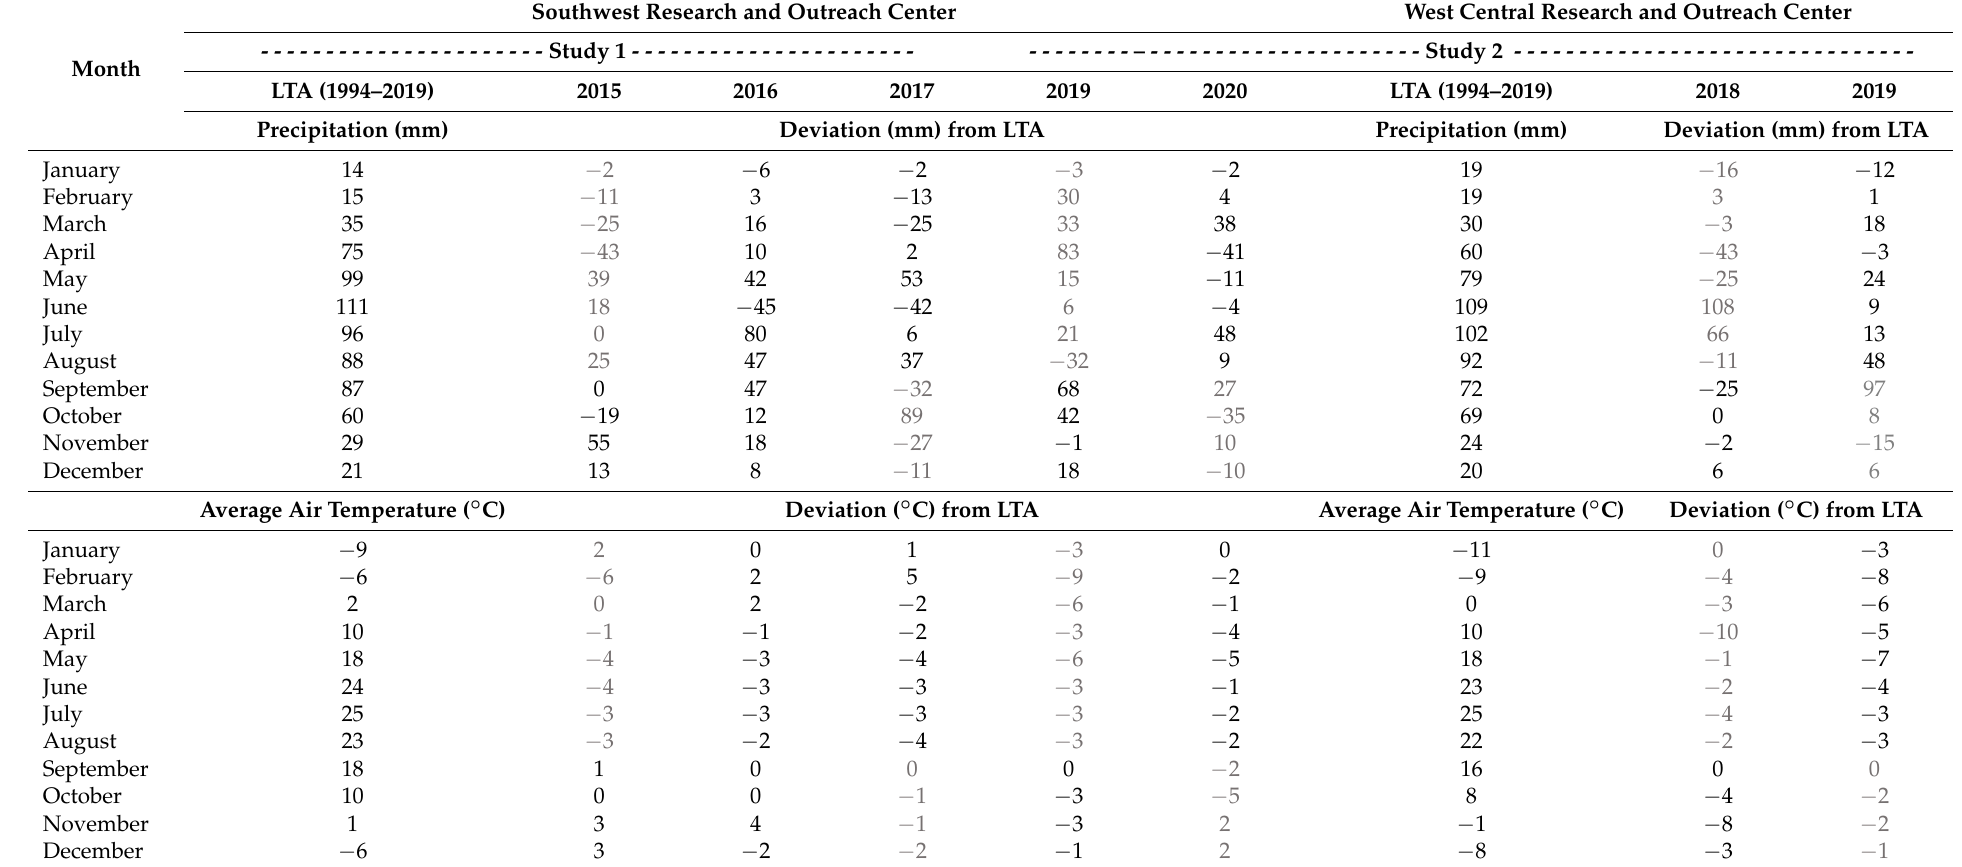
Table 2. Deviations from the long-term averages (LTA) of monthly precipitation and average air temperature (AT) at the experimental locations. Gray values denote periods of no field